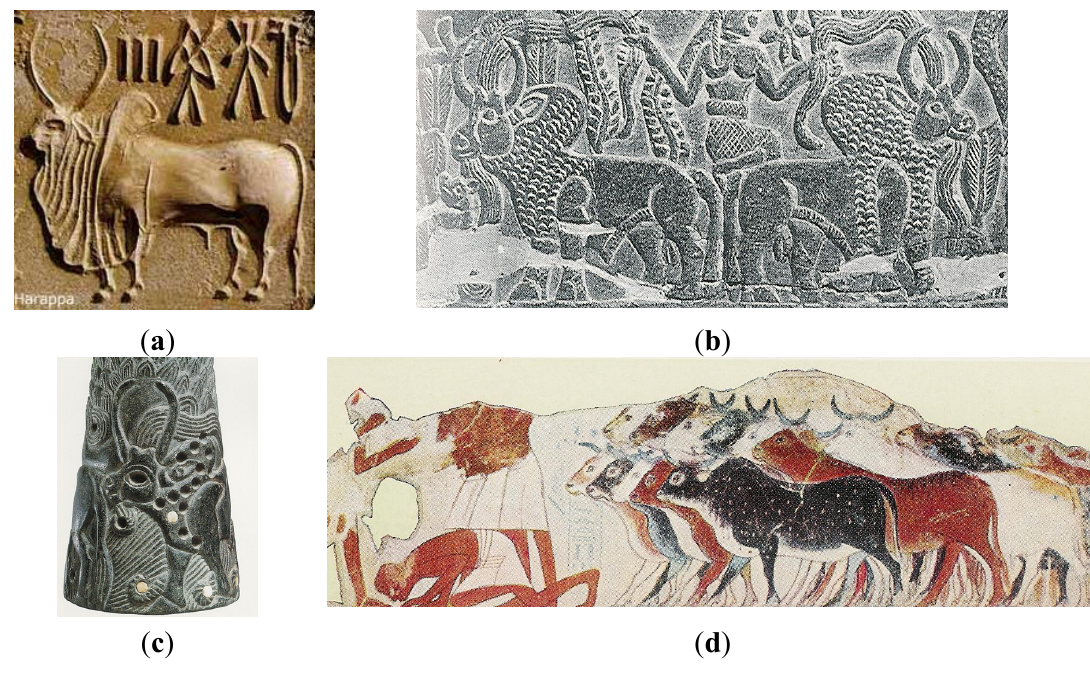
Figure 7. Pictorial evidence of the origin and dispersal of zebu. ( a ) Harappa seal (National Museum, India, [70]), 5000–3500 BP; ( b ) detail of cylindrical chlorite vessel (Mesopotamia (mid-5th millennium BP, The British Museum, London); ( c ) detail of conic object from Tarut Island near the Eastern coast of the Arabian peninsula (Metropolitan Museum, NY) and ( d ) detail of a painting: inspection of cattle belonging to Nebamun, Thebes, ca. 3400 BP, The British Museum,